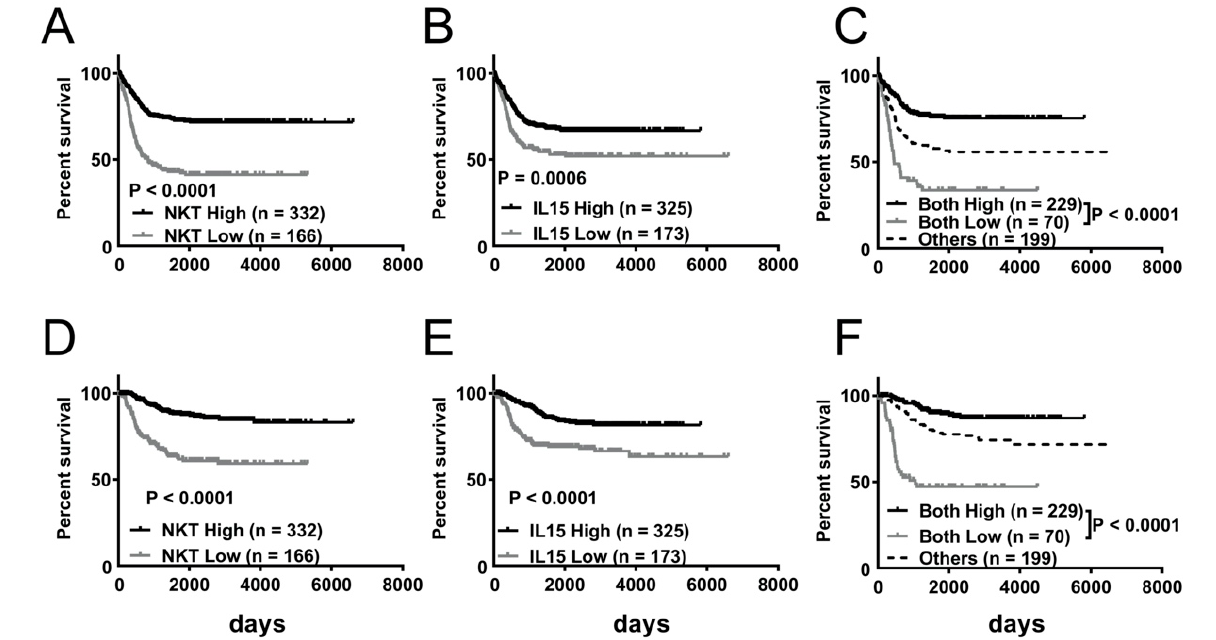
Figure 2. Survival benefit of greater abundance of natural killer T cell (NKT) and IL-15 expression in NBL dataset GSE49711. Kaplan–Meier curves showing event-free survival (EFS) ( A–C ) and overall survival (OS) ( D–F ) of NBL according to NKT immunoscore ( A , D ), IL-15 expression ( B , E ), and combined NKT immunoscore and IL-15 expression ( C , F ). Log-rank test was applied for statistical comparison.